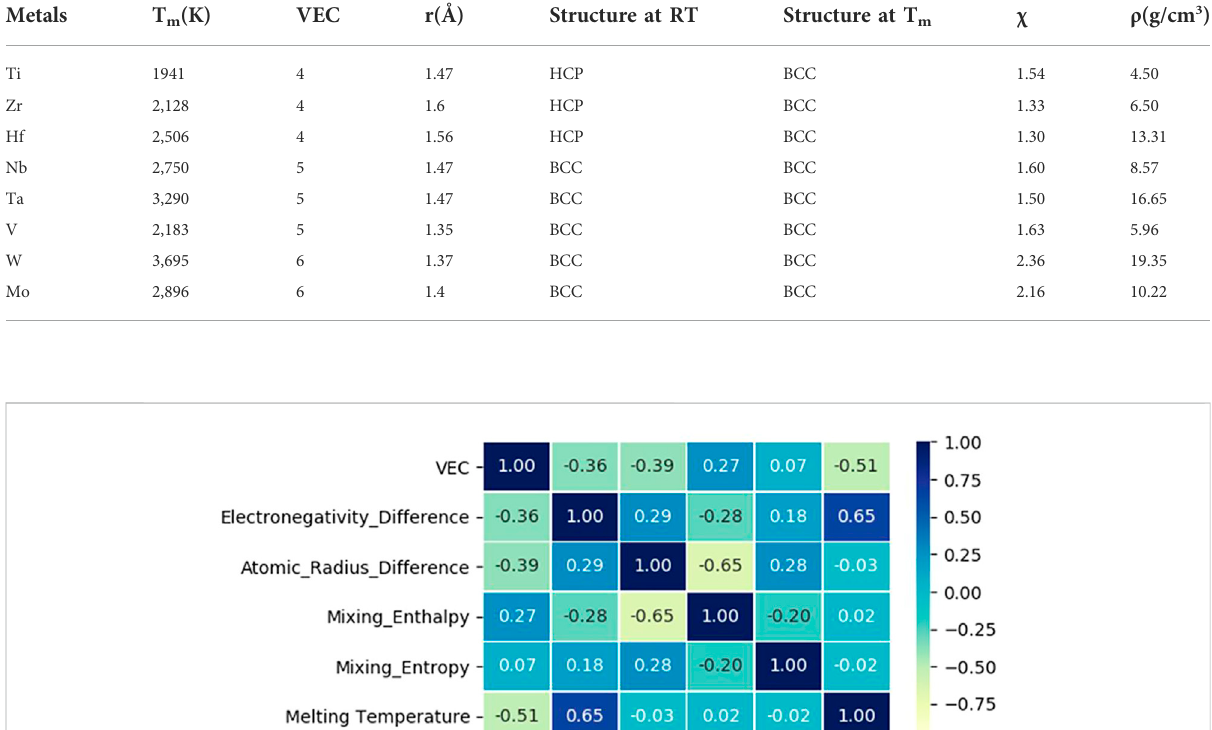
TABLE 1 Structure and properties of Bio-HEA elements.